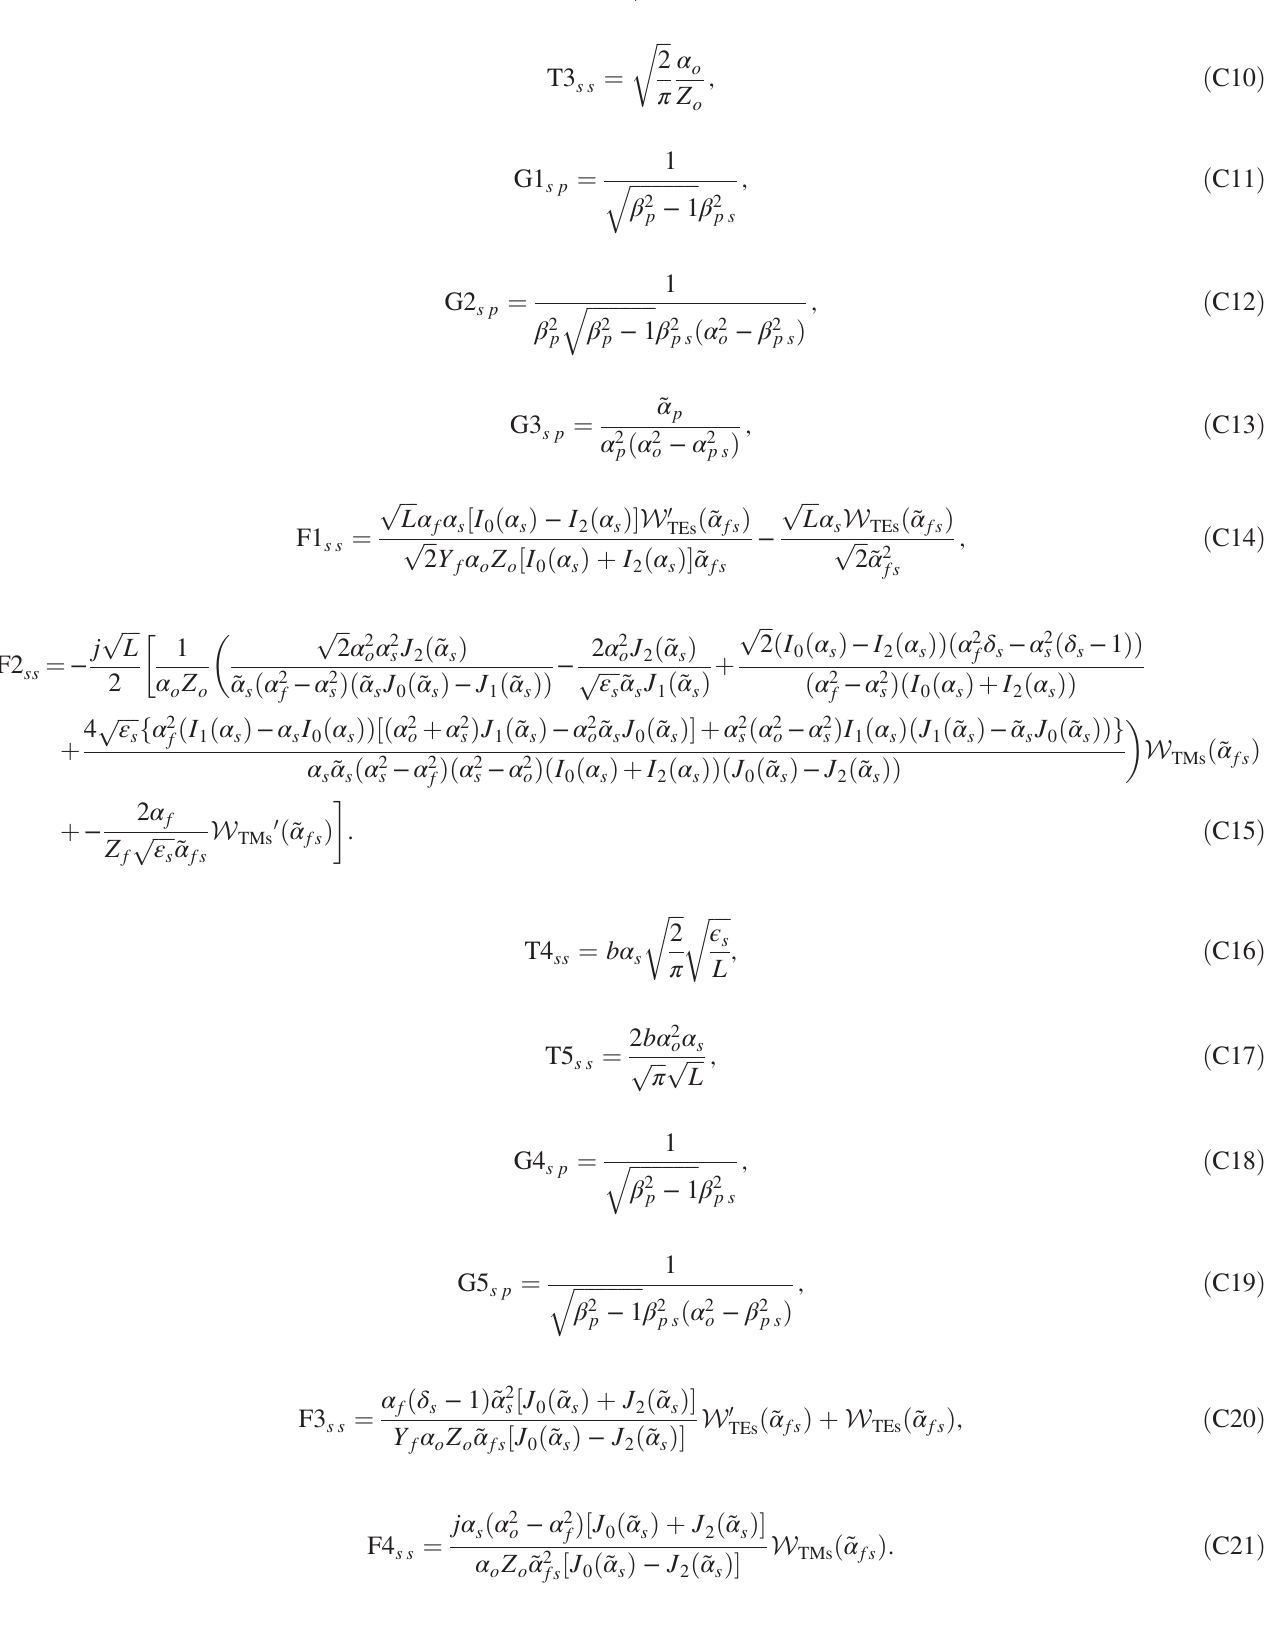
1 ffiffiffiffiffiffiffiffiffiffiffiffiffi